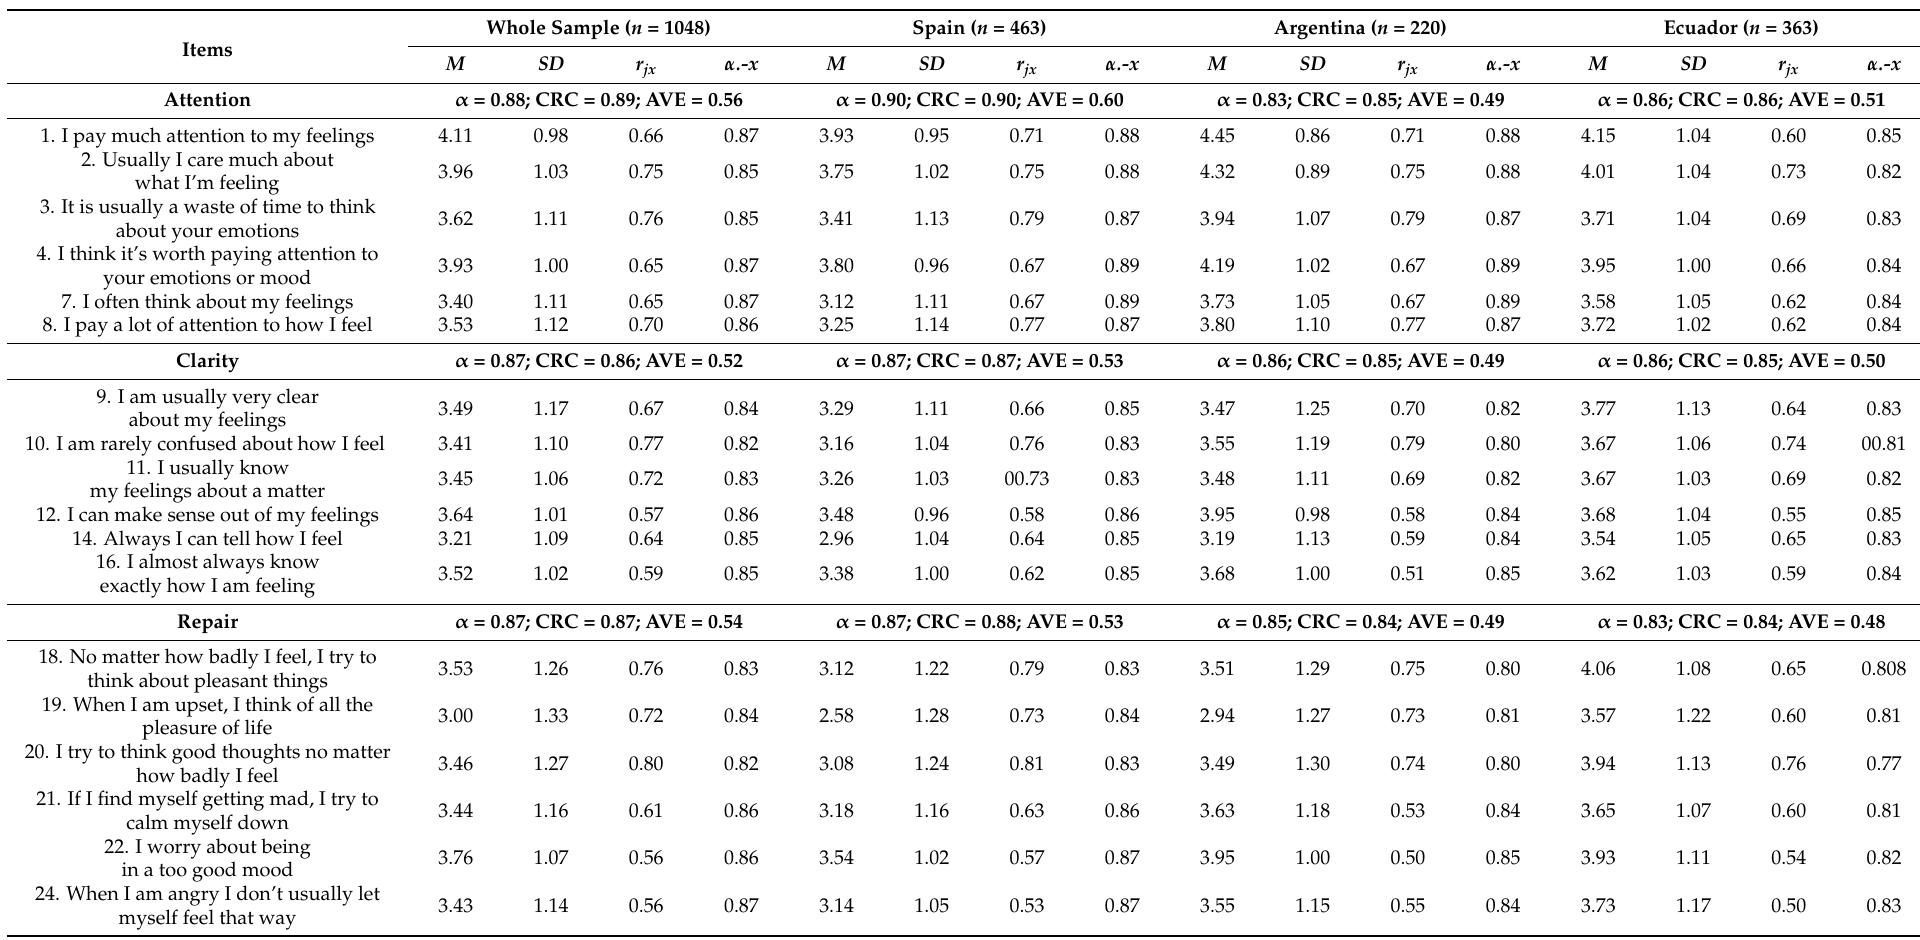
Table 1. Item analysis: Mean ( M ), standard deviation ( SD ), item-total correlation ( r jx ), and Cronbach’s alpha if item deleted ( α .-x ) in